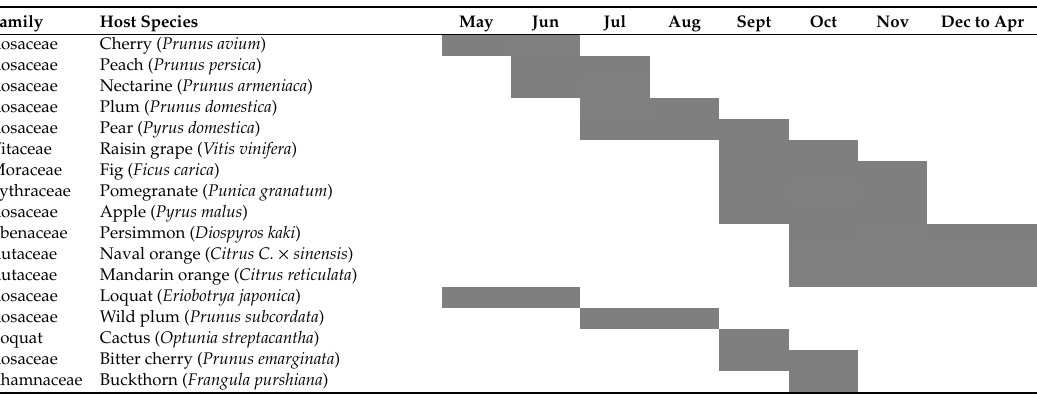
Table 1. Periods of fruit ripening and seasonal sampling for D. suzukii in crop and non-crop fruits in the San Joaquin Valley, CA,